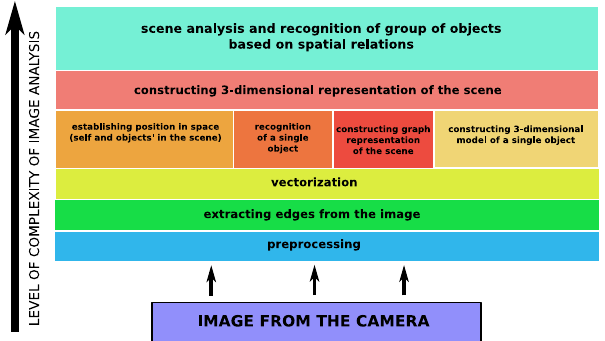
Figure 1. Structure of vision system of